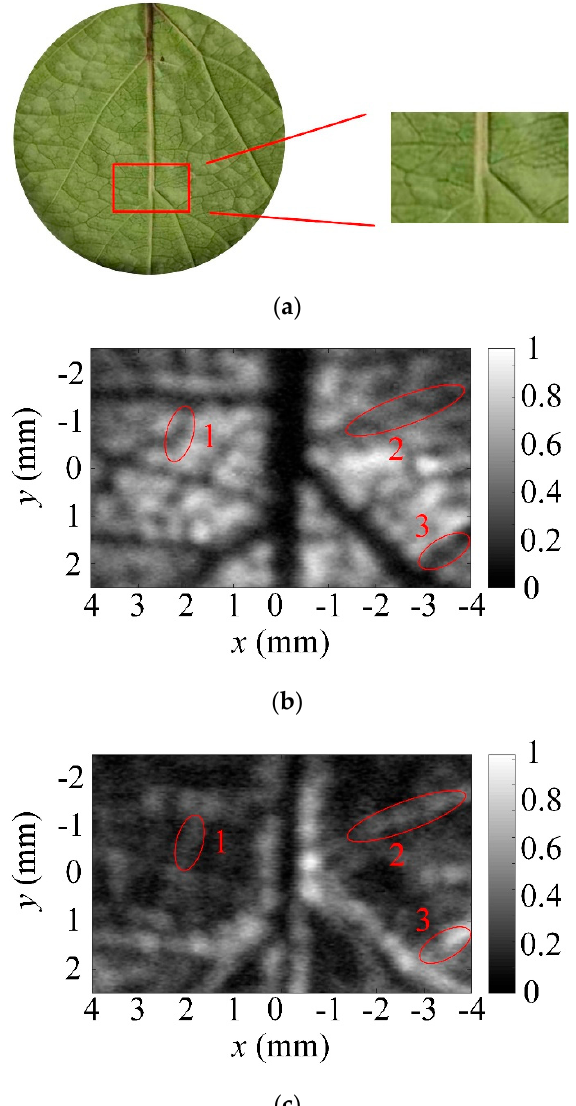
Figure 7. Experimental result for a leaf. ( a ) The optical image of the leaf. ( b ) The THz BF imaging result. ( c ) The THz SSF imaging result.